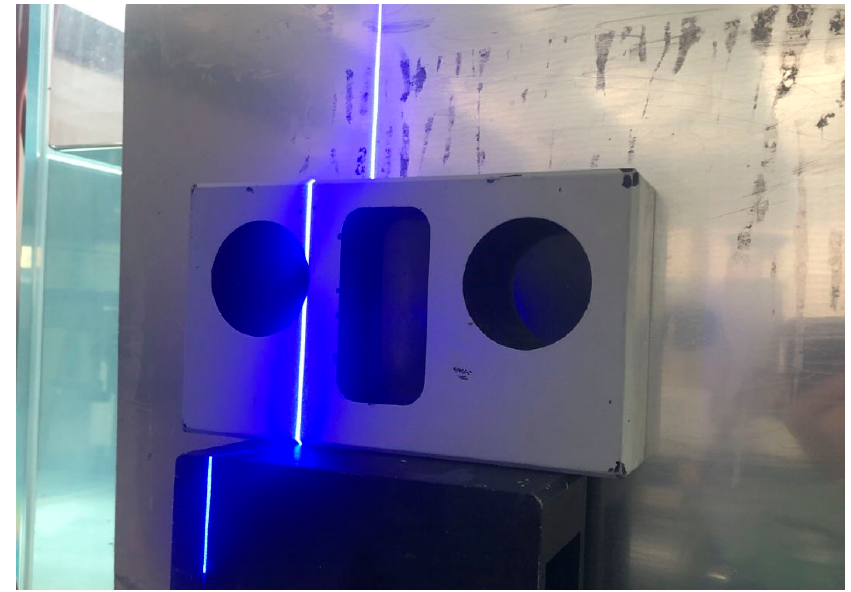
Figure 8. The measurement experiment of test piece.